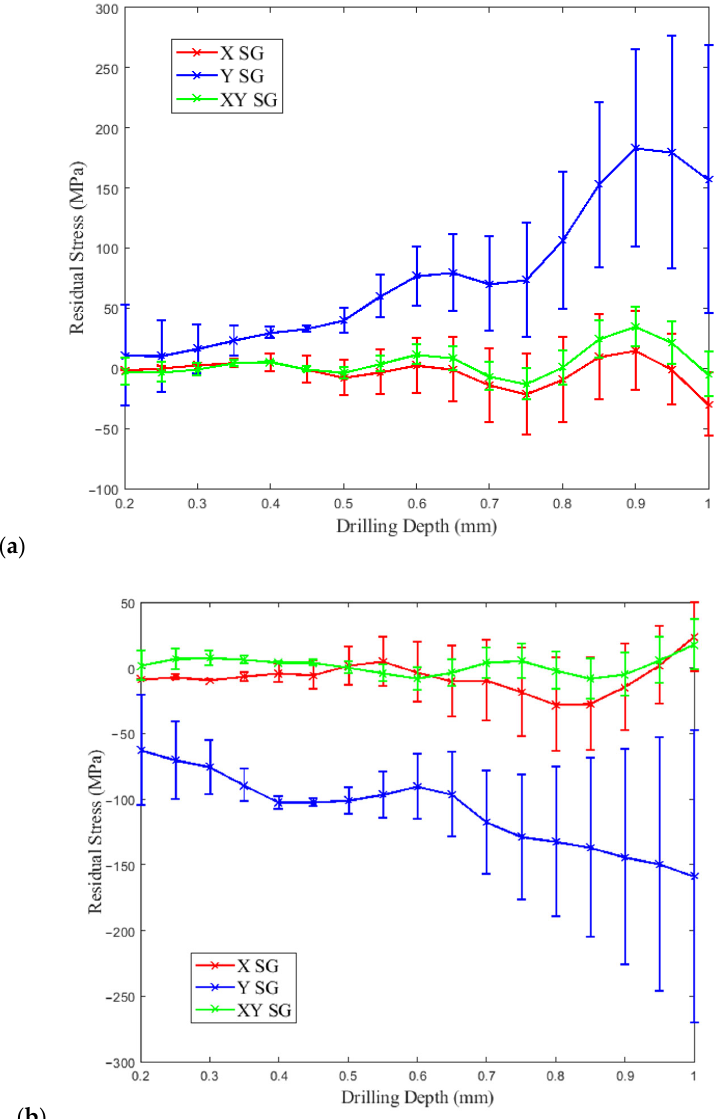
Figure 6. Cartesian stresses as a function of depth at ( a ) point T and ( b ) point